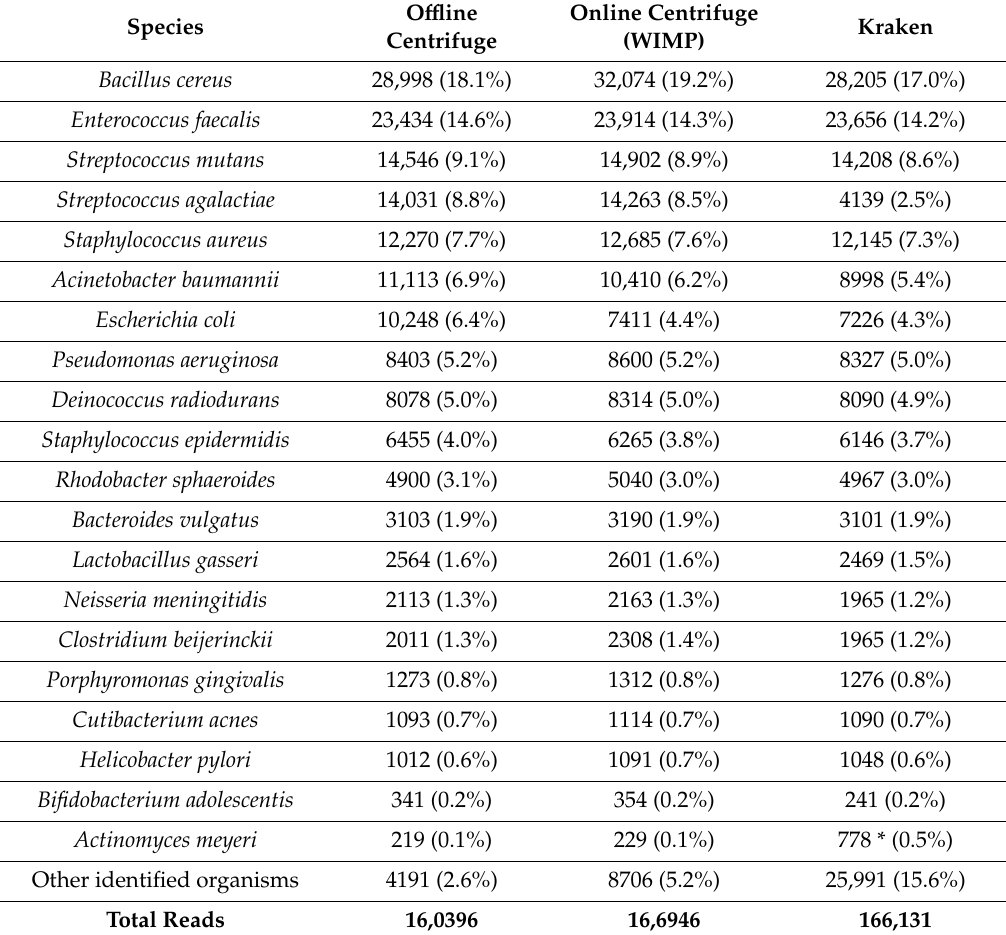
Table 3. Comparison of MINDS’ o ffl ine Centrifuge read mappers with ONT’s cloud-based Centrifuge (WIMP-What’s In My Pot) and Kraken read mappers. All three read mappers produced similar results except for Streptococcus agalactiae and Actinomyces meyeri as noted